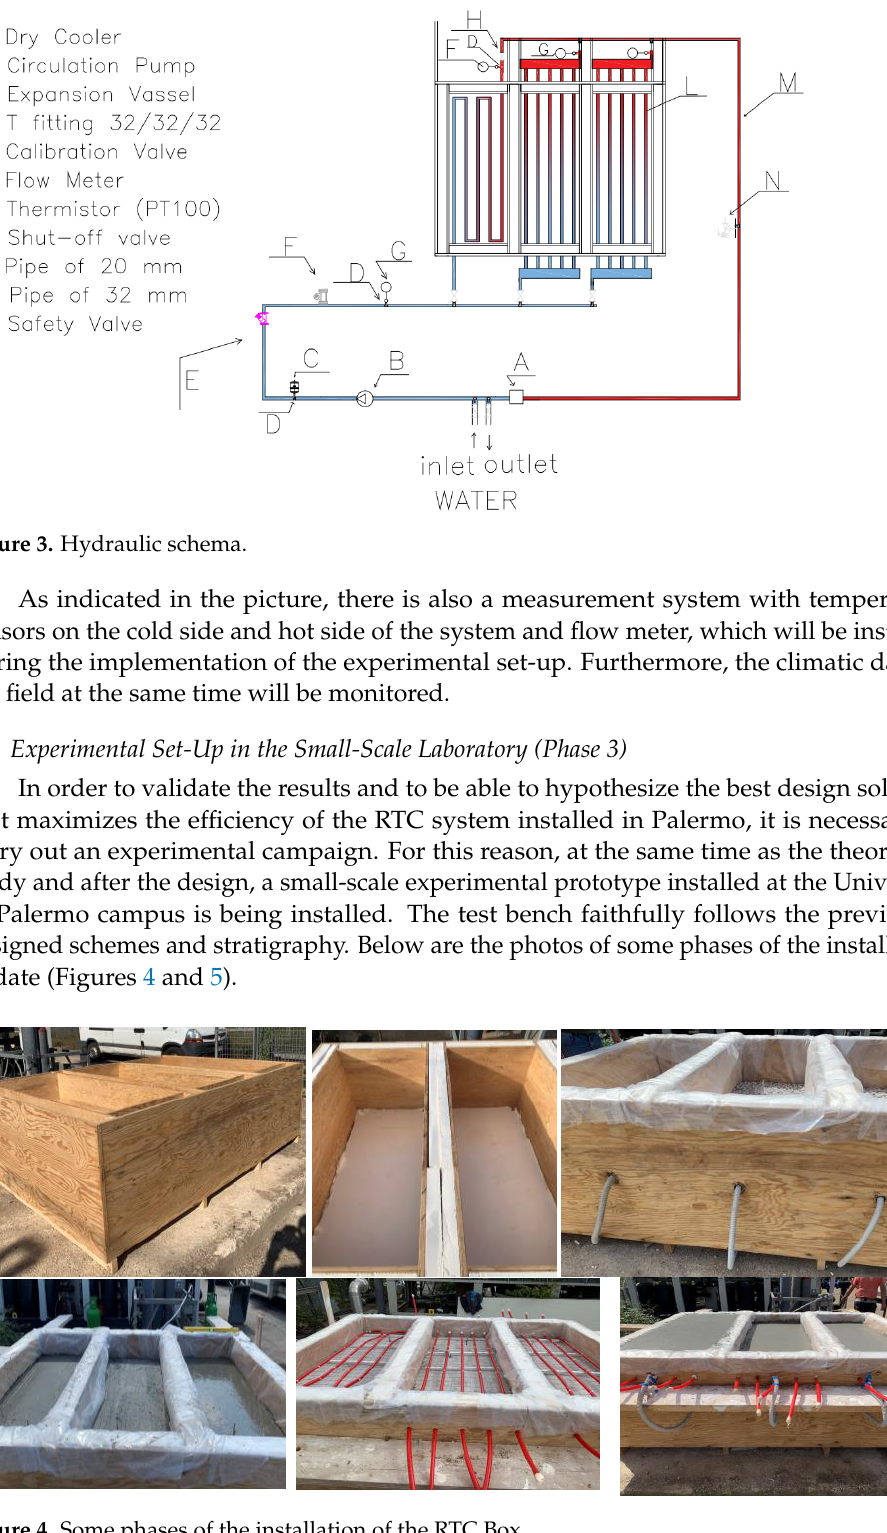
Figure 5. Some phases of the installation of the RTC Box. The prototype will be the experimental base in which to experiment in the field and on a small scale all the alternative solutions previously hypothesized and others that will be considered appropriate, in this way, it will be identified as the best solution to be im- plemented in the Mediterranean area. In detail, the small-scale prototype was born from the idea of being able to experiment on a reduced model with different geometric config- urations, materials and alternations of stratigraphy’s that can represent an alternative and improved solution to the model envisaged on a large scale. In detail, the research group decided to develop a dynamic model that is calibrated with the data monitored in the field. A dynamic model, created with the TRNSYS software (Thermal Energy System Spe- cialists, LLC, Madison, USA) with data in the field will then be validated, guaranteeing the reliability of the results. In this way, the effects of the application of alternative solu- tions, configurations, and/or materials to the basic configuration will be predicted numer- ically, also allowing a parametric analysis for the identification of the best solution. In order to assess whether a solution, configuration, and/or choice of alternative material packages highly reliable in the field, a small-scale field trial is necessary. This set-up, thanks to its small size, will allow one to experiment with various solutions, to select those that make the system more efficient, reducing time and, above all, costs. For example, the step of adding a small area of road pavement, which may not lead to expected results, does not impact economically as that of adding the entire experimental area. Figure 6 pre- sents some stages of laying of the RTC system at the UNIPA experimental area; this phase is being completed.